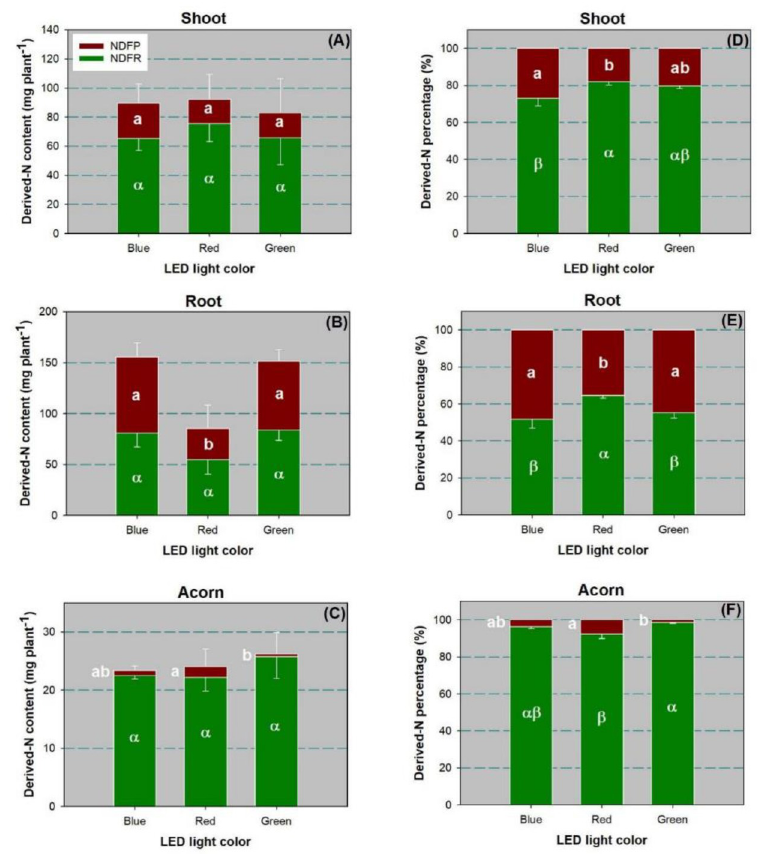
Fig 7. Amount and percent of nitrogen (N) derived from pulses (NDFP) and plant reserves (NDFR) in shoots (A, D), roots (B,E), and acorns (C,F) of Chinese cork oak ( Quercus variabilis Blume) seedlings subjected to blue, red, and green LED spectra ( n = 24). Columns and bars represent means and standard errors, respectively. Different letters denote a significant difference according to Tukey’s test at the 0.05